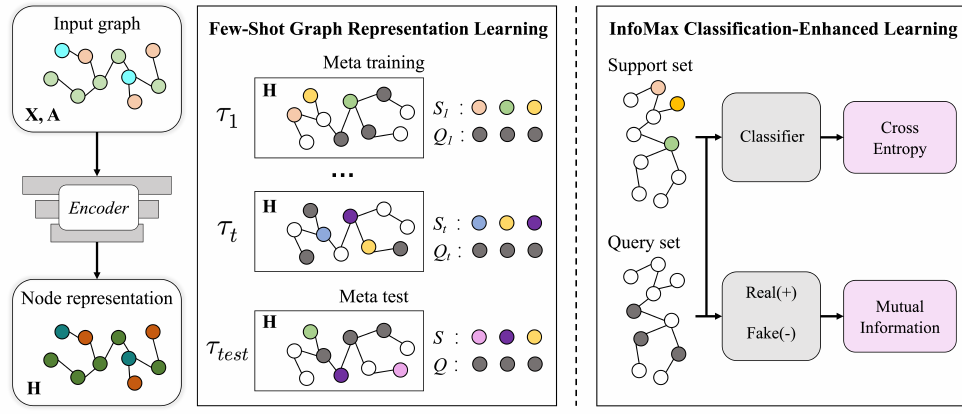
Figure 1. Overall flow and framework of the proposed